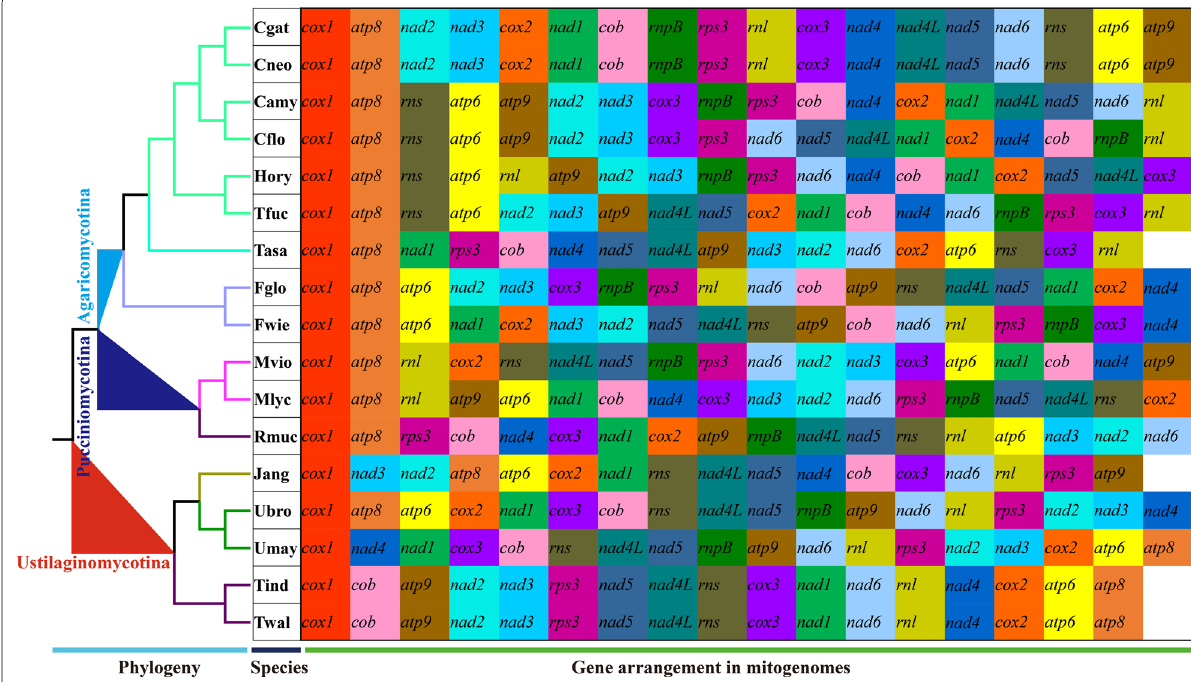
Fig. 6 Mitochondrial gene arrangement analyses of 17 mitochondrial genomes from Agaricomycotina , Pucciniomycotina and Ustilaginomycotina . The same gene were represented by same color blocks. Phylogenetic positions of the 17 species were established using the Bayesian inference (BI) method and Maximum Likelihood (ML) method based on concatenated mitochondrial genes. Species information is shown in Additional file 1: Table S7